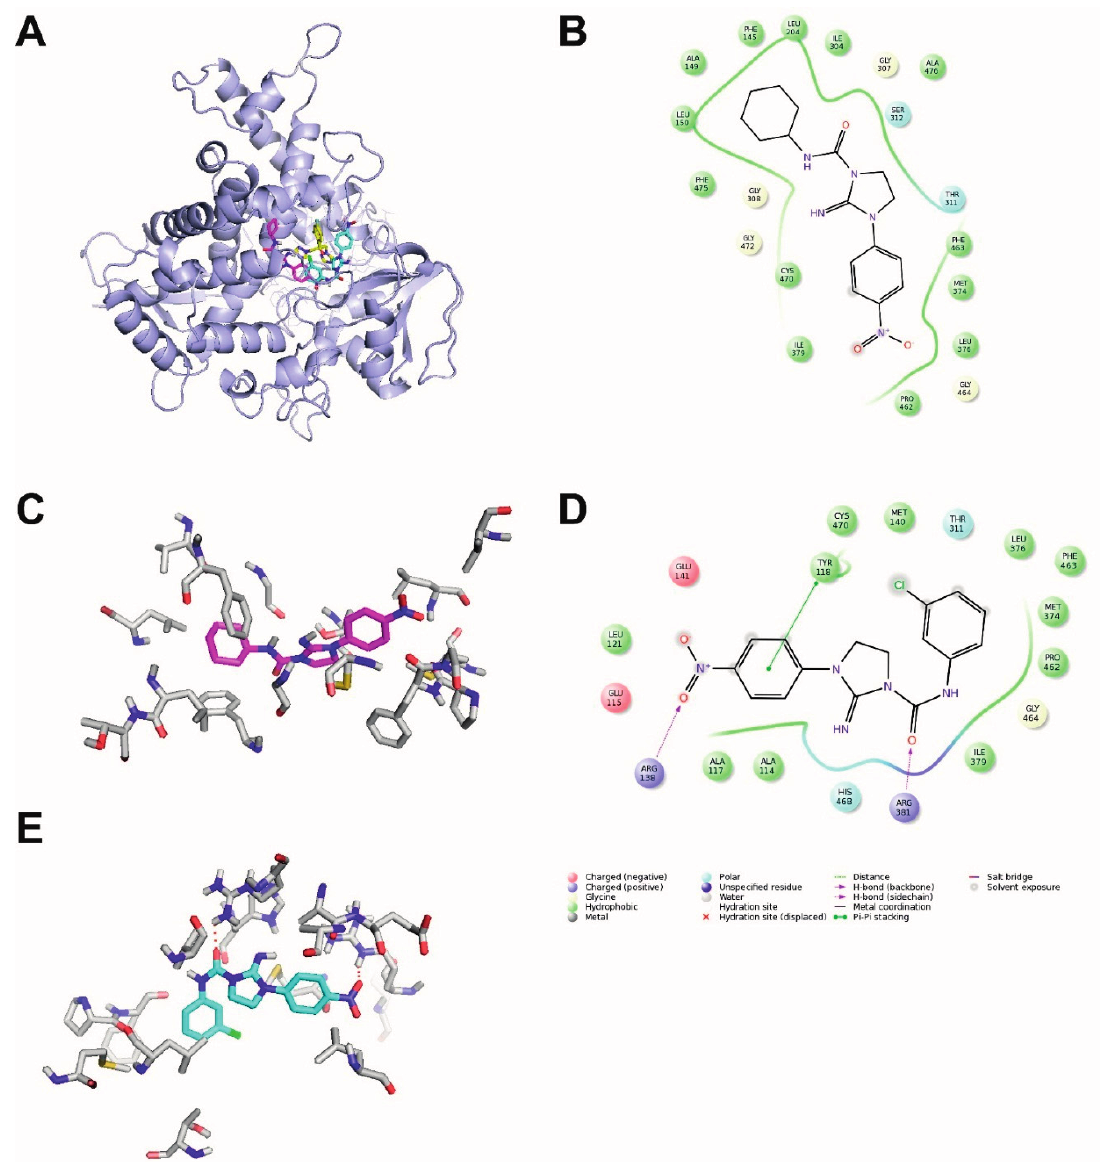
Figure 4. Molecular interactions of 4a and 4f with cytochrome P450 14- α -sterol demethylase (homology model) from Candida albicans . ( A ) comparison of binding poses of fluconazole (yellow carbon atoms), inactive 4a (cyan carbon atoms) and active 4f (magenta carbon atoms). Protein shown in cartoon representation, ligands shown as sticks. Non-polar hydrogen atoms omitted for clarity; ( B ) 2D map of binding site for 4f ; ( C ) details of binding site of 4f . Ligand and protein shown as sticks with magenta and grey carbon atoms, respectively. Non-polar hydrogen atoms omitted for clarity; ( D ) 2D map of the binding site of 4a ; ( E ) details of binding site of 4a . Ligand and protein shown as sticks with cyan and grey carbon atoms, respectively. Hydrogen bonds shown as red dashed lines. Non-polar hydrogen atoms omitted for